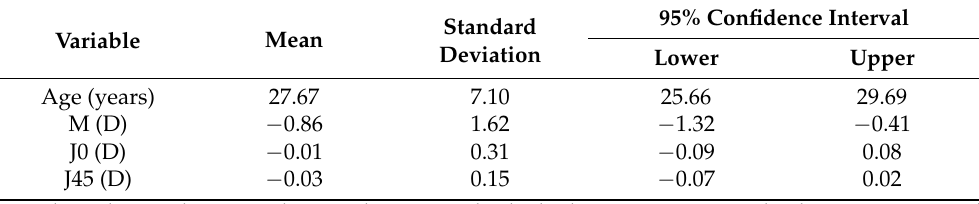
Table 1. Characteristics of the general sample ( n =